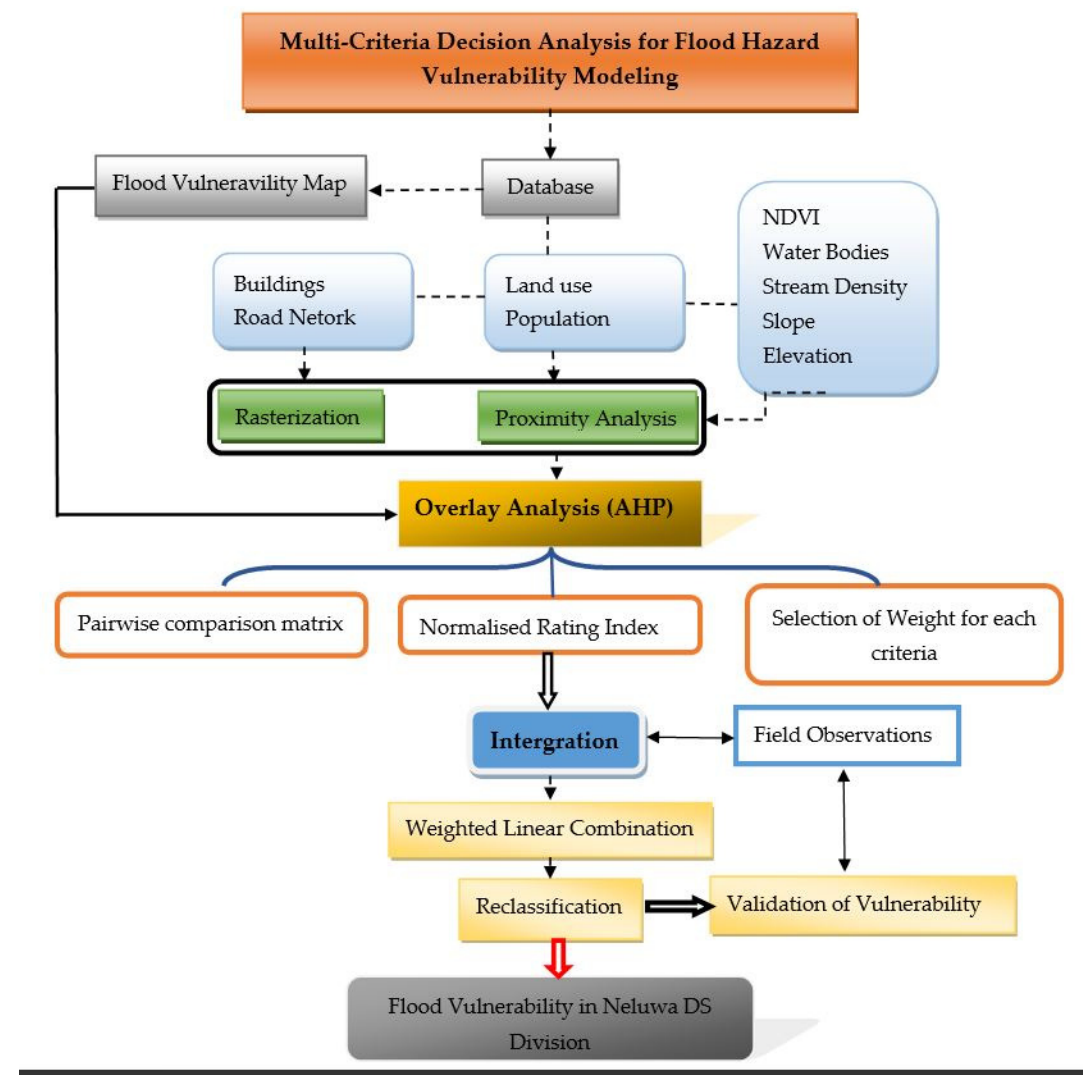
Figure 3. Spatial analysis procedure of the study.